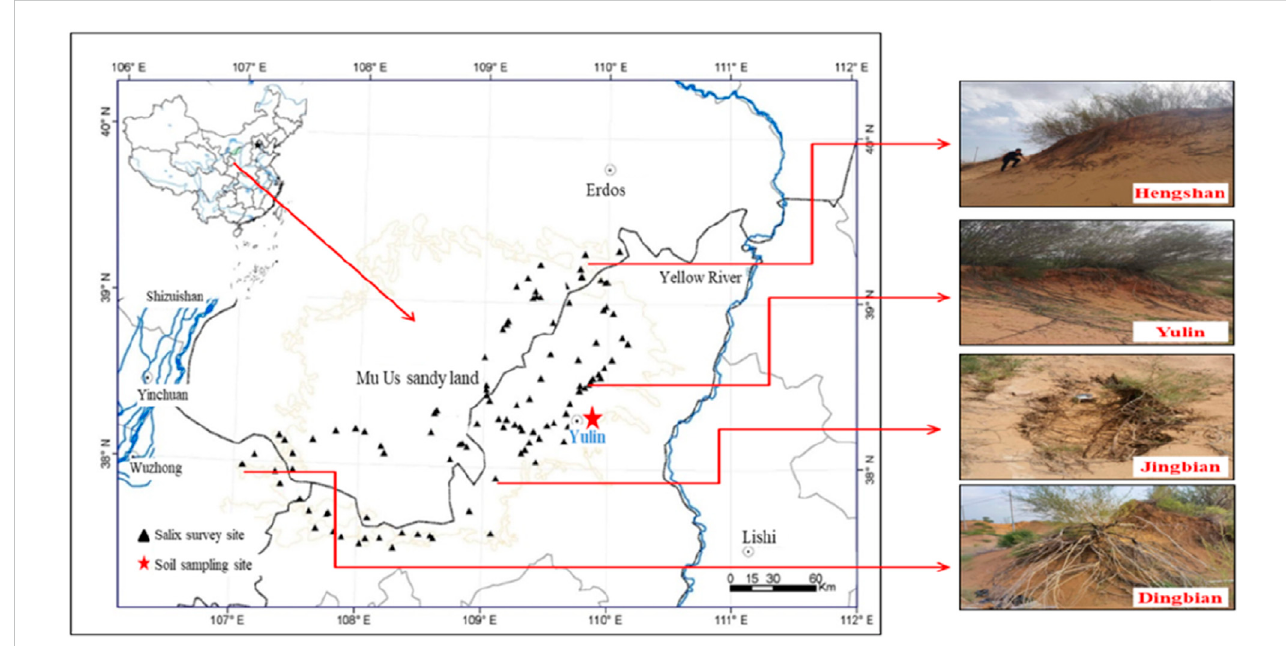
FIGURE 1 Distribution of the S. psammophila survey site and soil sampling site in the water – wind crisscrossed erosion region of the Chinese Loess